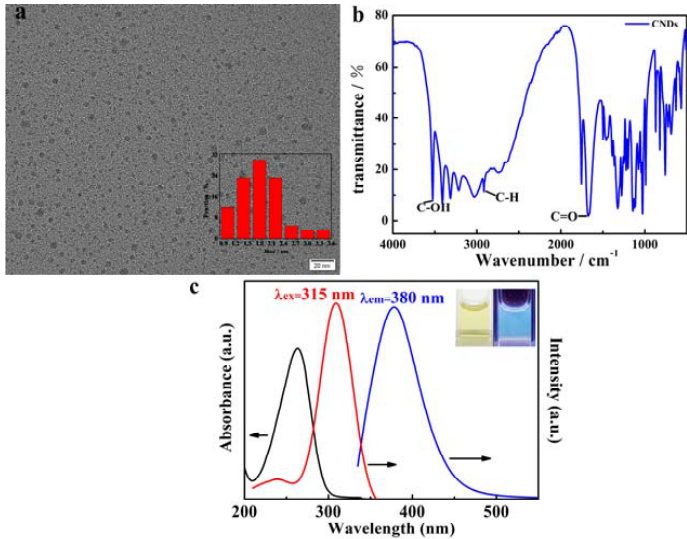
Figure 1. TEM image ( a ), FT ‐ IR spectrum ( b ), UV–VIS absorption (black curve), and fluorescence emission (blue curve), and excitation (red curve) spectra of CNDs ( c ). The inset of ( c ) is the photograph of CNDs under visible light and UV light at 365 nm.